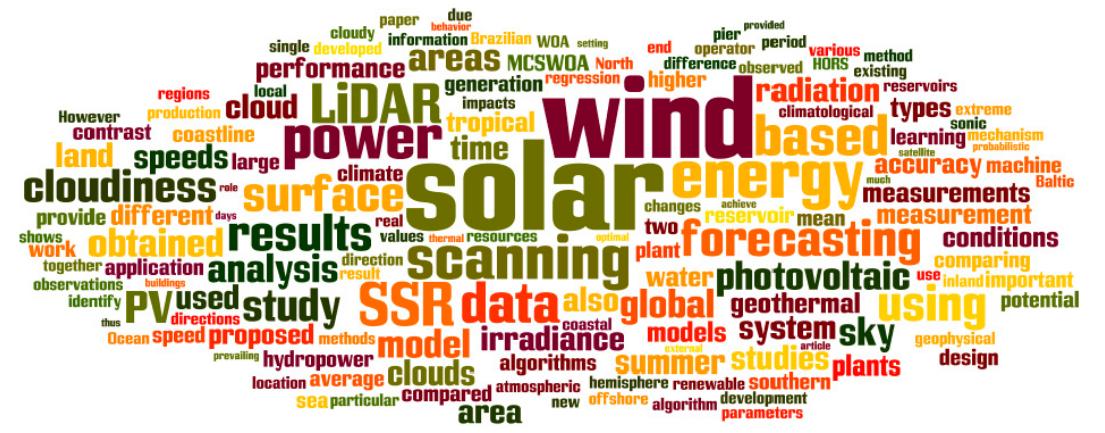
Figure 1. Illustrative map prepared using the words composing the Abstract of the eleven articles published in the Special Issue “Assessment of Renewable Energy Resources with Remote Sensing” of Remote